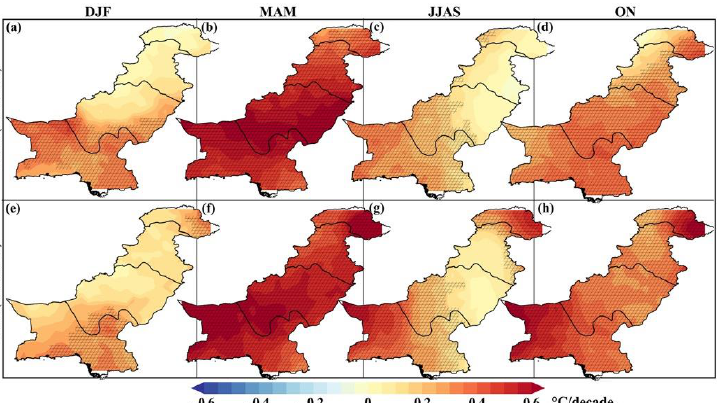
Figure 9. Spatial distribution of Mann – Kendal trend (°C/decade) of maximum temperature (Tmax) during the ( a ) DJF (December to February), ( b ) MAM (March to May), ( c ) JJAS (June to September), and ( d ) ON (October to November) Season over the China Pakistan Economic Corridor for 1980 – 2018. Lower panels (e-h) are the same as top panels but for the minimum temperature (Tmin). The hatched area shows a statistically significant trend at a 90% confidence level. R-I, R-II, R-III, and R-IV represent the hyper-arid, arid, humid, and glacial regions, respectively. During the JJAS season, Tmax and Tmin in R-I and south, southwest part of R-II showed a statistically significant increasing trend, while Tmax in R-IV also depicts a sta-